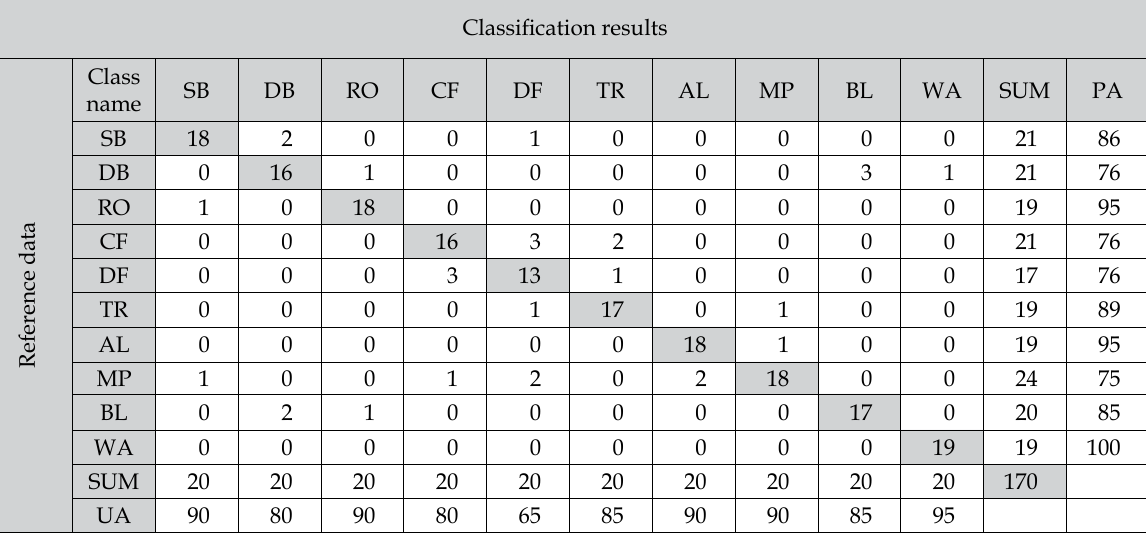
table 5. error matrix for the dzieckowice water catchment area (3.905